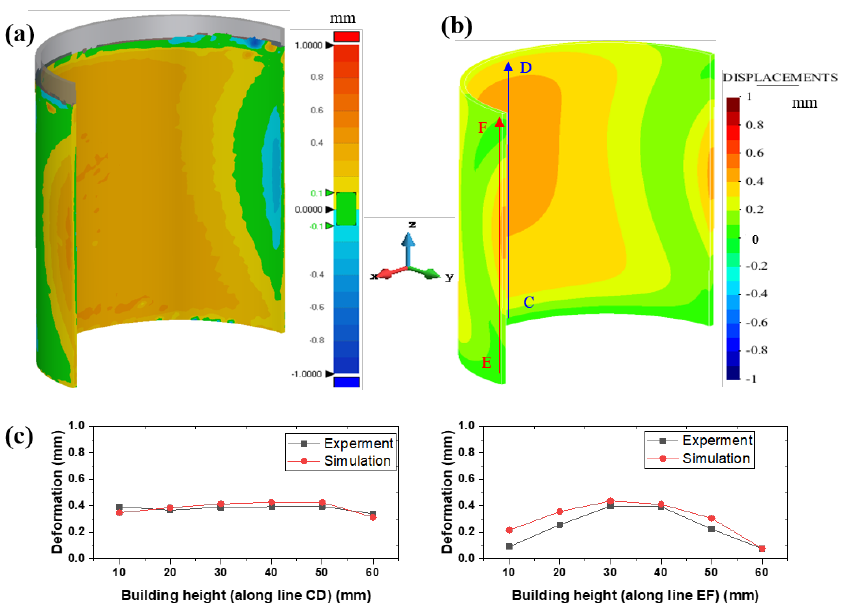
Figure 7. Semi − cylindrical (SC1) part: comparison between the ( a ) experimental and ( b ) simulated displacement distribution. ( c ) The deformation distribution along the lines CD and EF, which are located at the center of the inner surface and at the edge of the outer surface, respectively.